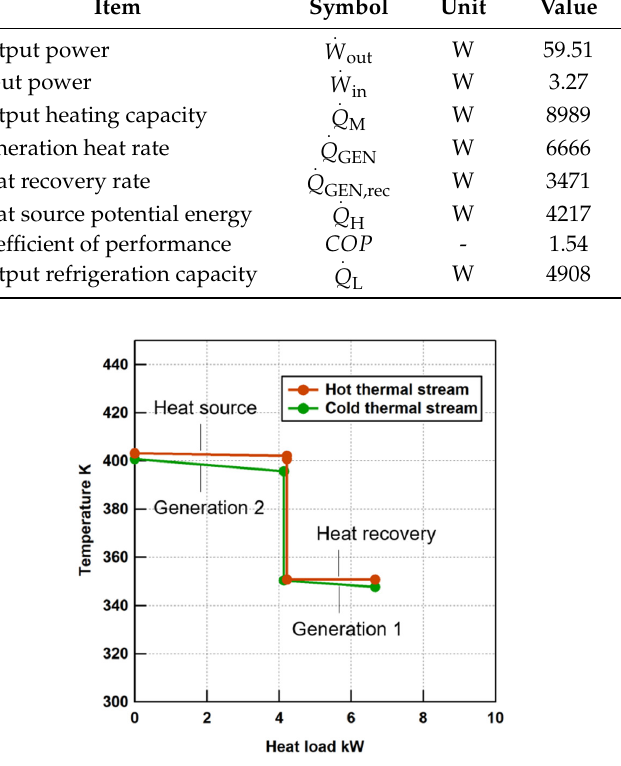
Figure 11. Composite curves of the optimal solutions in case Y. Table 3. Calculated values about the energy exchange rate in case Y.